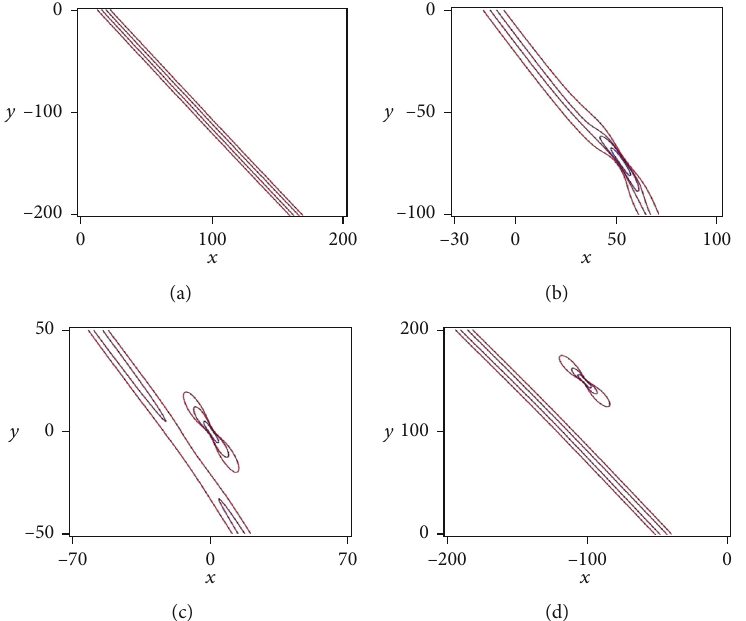
= 1/20 , a = 2 , k = 1/10 , a 1 5